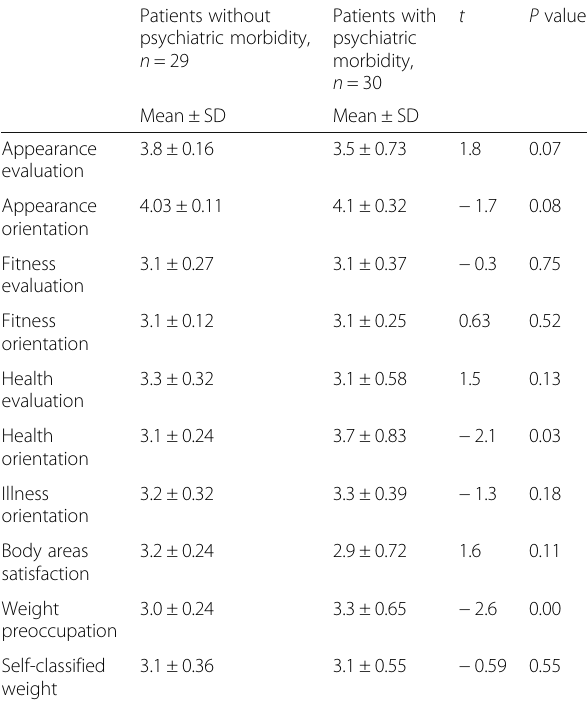
Table 3 Comparison of self-image between subjects with and without psychiatric morbidity Patients without psychiatric morbidity,